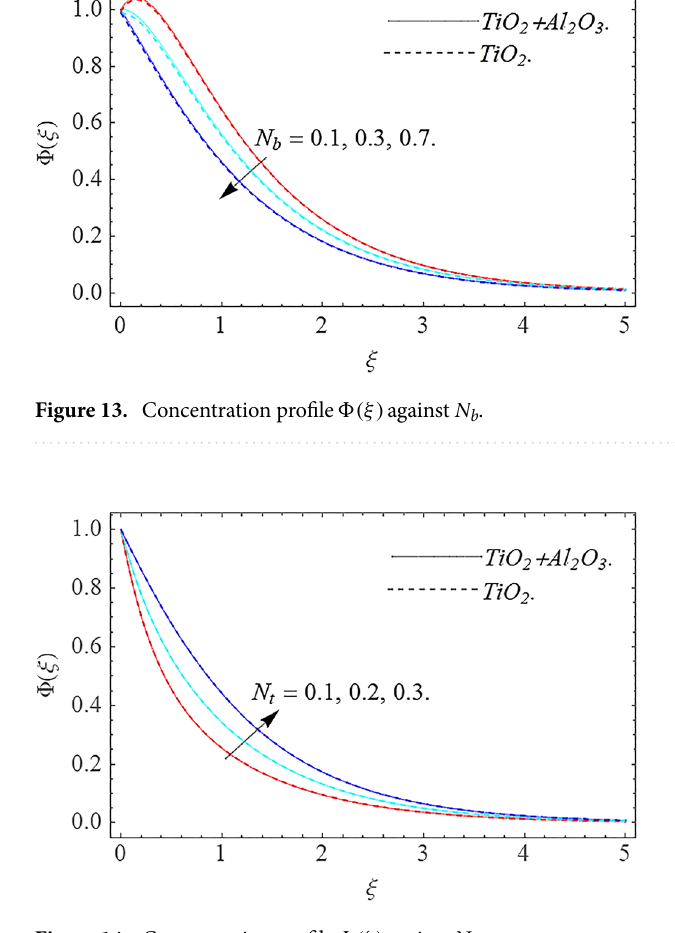
Figure 14. Concentration profile �(ξ) against N t .